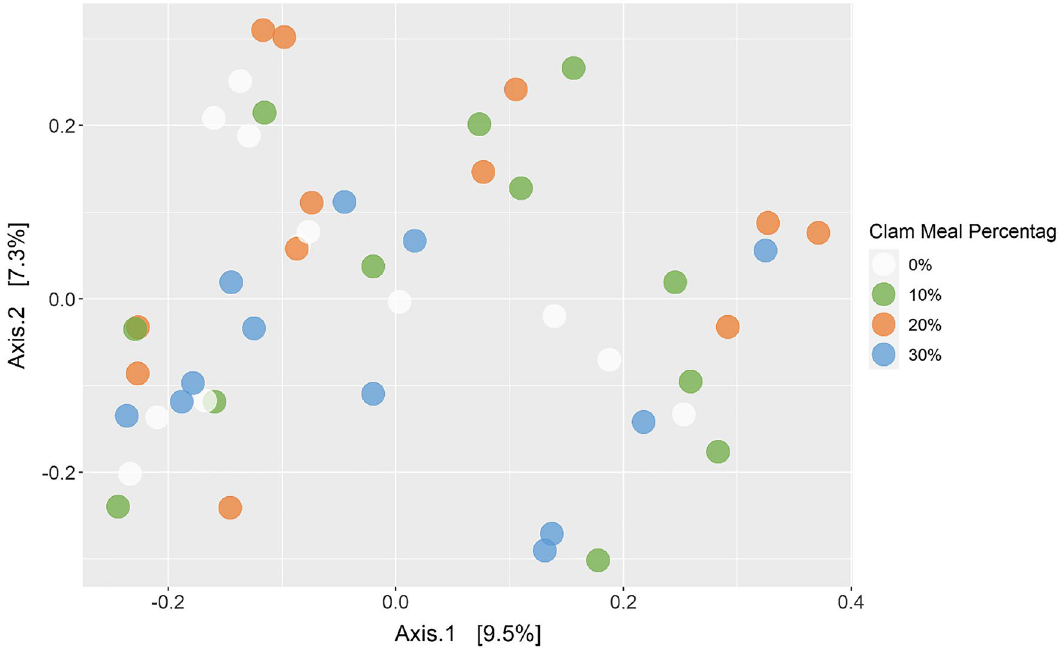
Figure 7. Principle coordinates of analysis of gut samples using a Bray–Curtis dissimilarity matrix after square root transformation. Color represents clam meal incorporation as a percent of the dry diet with white representing 0% (control), green 10%, orange 20%, and blue 30%.